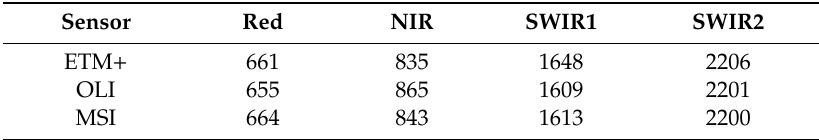
Table 1. Band centers for Landsat 7 ETM + , Landsat 8 OLI and Sentinel 2 MSI, in nanometers, adapted from Pahlevan et al. [41].